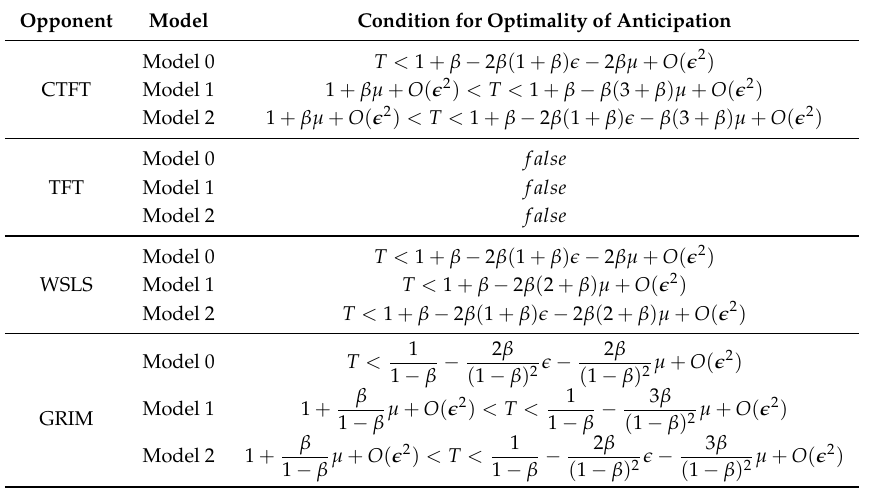
Table 6. Conditions in which anticipation is optimal in the additive PD. Here, we assume S < 0, T > 1 and S + T = 1. Note that (cid:101) ≡ ( (cid:101) , µ )